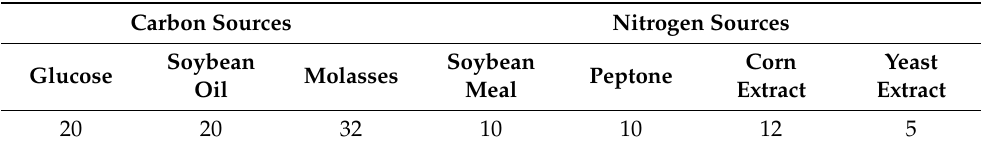
Table 1. Concentrations of carbon and nitrogen sources (g/L) in liquid media for submerged cultivation of F. velutipes